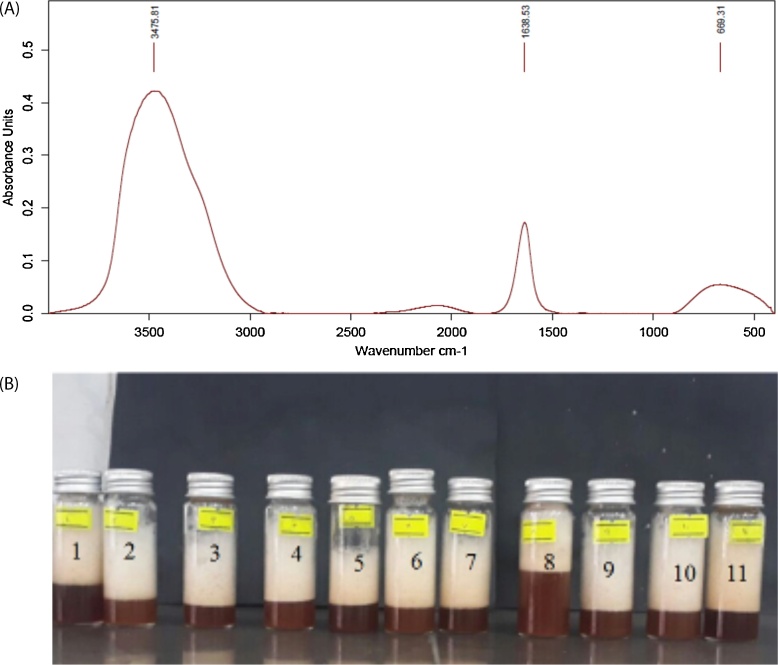
FT-IR spectrum of the extracted saponin (A) and foam height of the extracted solutions containing saponin according to the CCD (B).